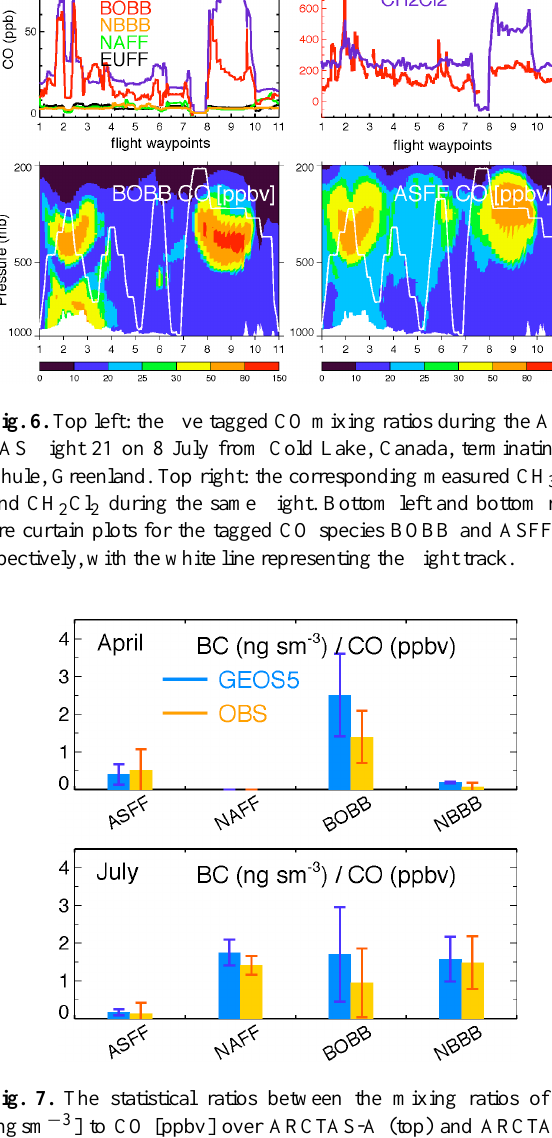
Table 3. The ratio of BC/CO (GgTg − 1 ) from emissions in differ- ent source regions and from Arctic air samples in